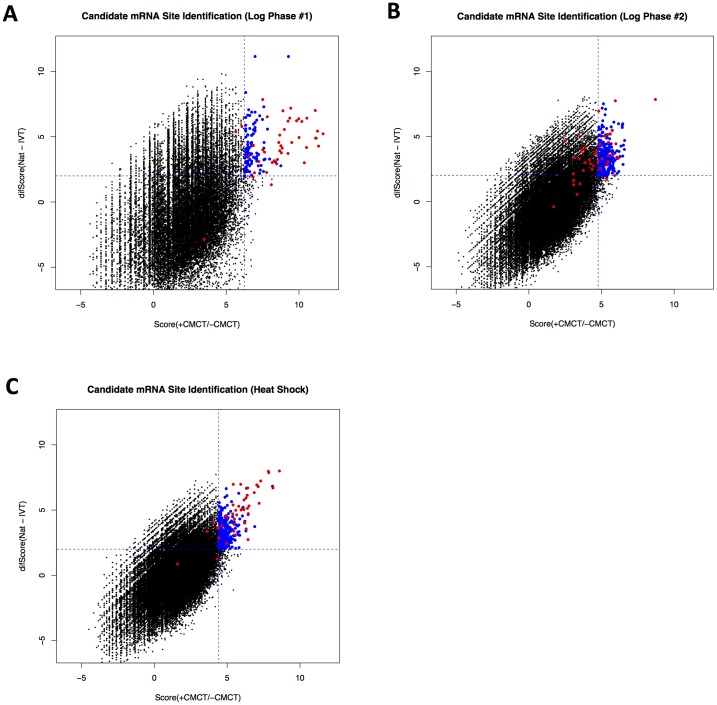
PSI-Seq Analysis of the Yeast Transcriptome Reveals mRNA Pseudouridylation Sites.(A–B). For RNA isolated from yeast growing in log phase (A–B) or heat shock (C) conditions, pseudouridylation “scores” were calculated based on a regression analysis of the log2 transformed normalized read densities for each nucleotide position in treated (+CMCT) versus mock (-CMCT) samples (details in text). Values plotted on the x-axis indicate scores (+CMCT/−CMCT) from PSI-seq analysis of natural RNA samples. Values plotted on the y-axis indicate the difference between the natural RNA (+CMCT/−CMCT) scores and the corresponding score values obtained from PSI-seq analysis of unmodified in vitro transcribed control RNA samples. Each data point corresponds to a single nucleotide position within the transcriptome. Vertical and horizontal dashed blue lines illustrate the cutoff thresholds used as criteria for candidate pseudouridine identification for each experiment. Unique non-rRNA-derived uridine sites in the upper-right quadrant were classified as candidate mRNA pseudouridines (blue circles). Known pseudouridine sites from the ribosomal RNA are also shown (red circles).